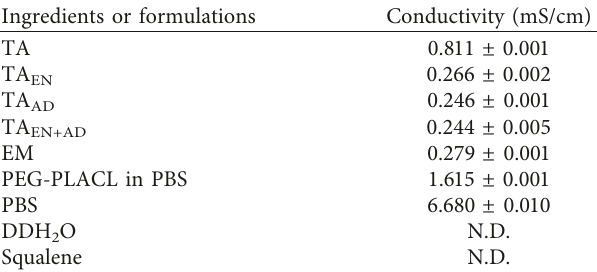
Table 2: Conductivity of ingredients and formulations used in this study (mean ± standard deviation, n � 3).